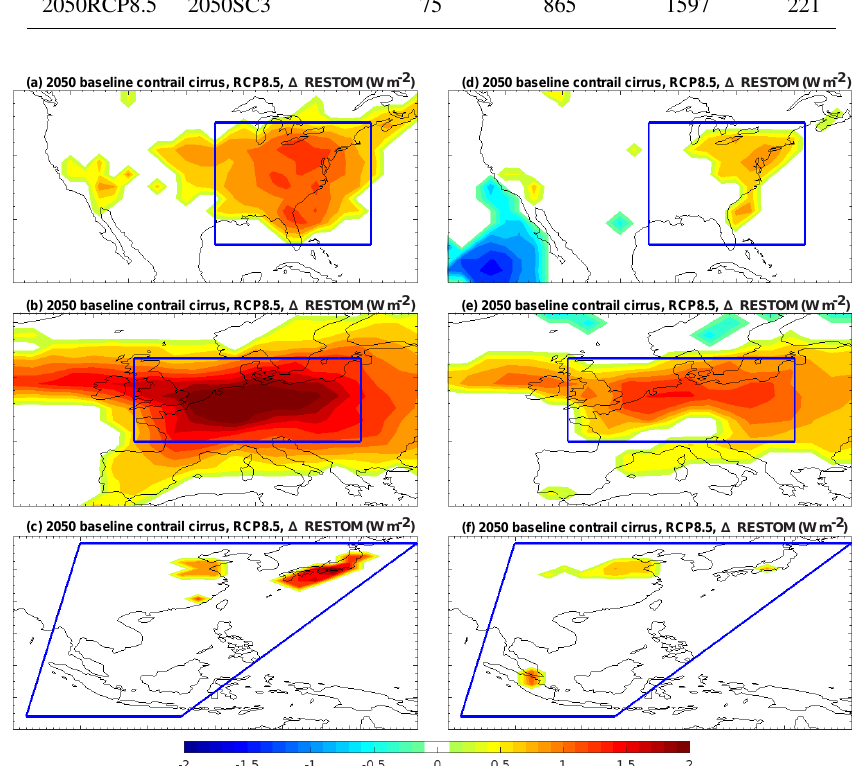
Figure 6. Ensemble mean of regional radiative forcing in Wm − 2 based on the baseline emission scenario in 2050 with RCP8.5 2050 meteorology due to contrail cirrus (a–c) and contrail cirrus and aviation aerosols (d–f) . Only ensemble-mean perturbations above 2 standard deviations of the averaged control simulations are considered in